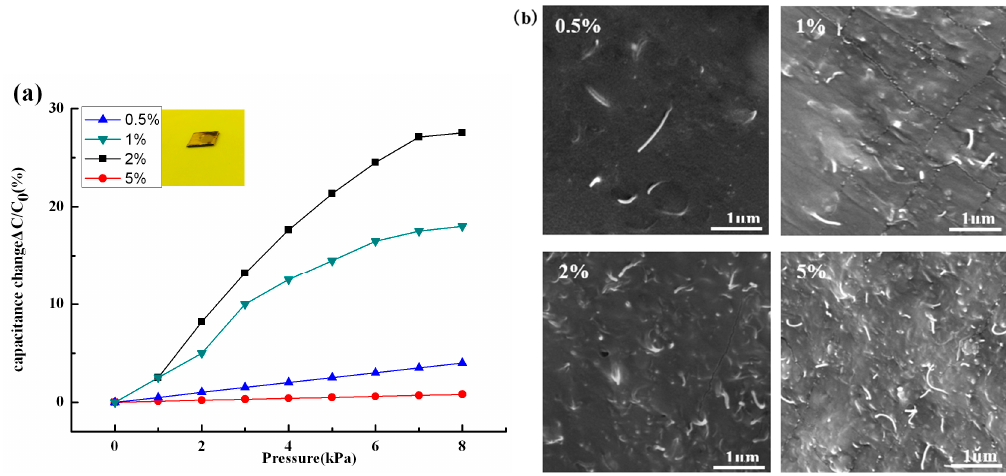
Figure 2. Characterization of different volume fraction of CNTs/PDMS elastomers. ( a ) Mechanical capacitance response of square CNTs/PDMS film (8 mm × 8 mm × 0.5 mm); ( b ) SEM images of CNTs/PDMS elastomers with different CNT concentrations.